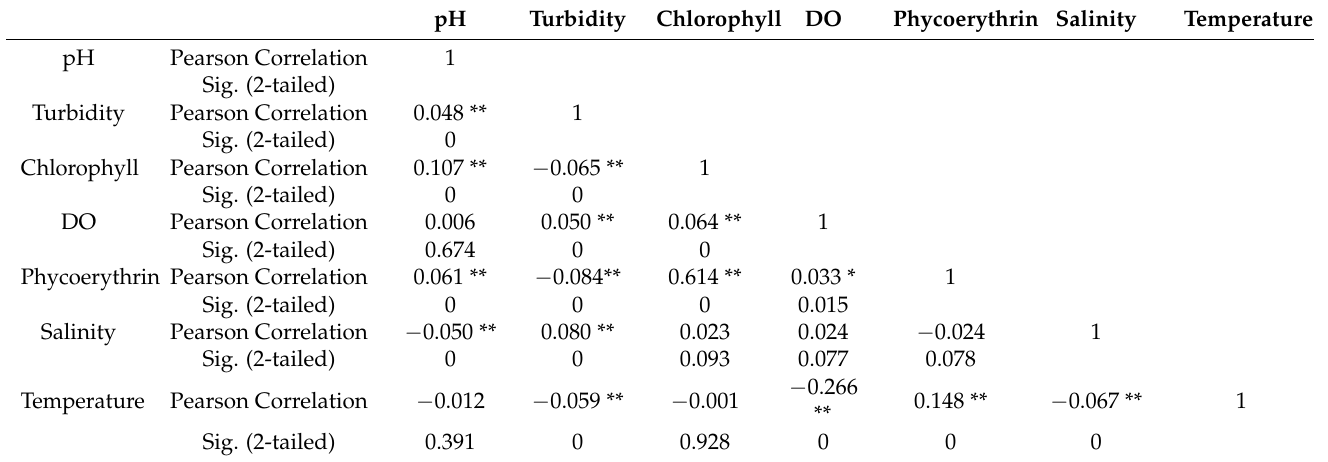
Table 6. Pearson correlation matrix based on the overall